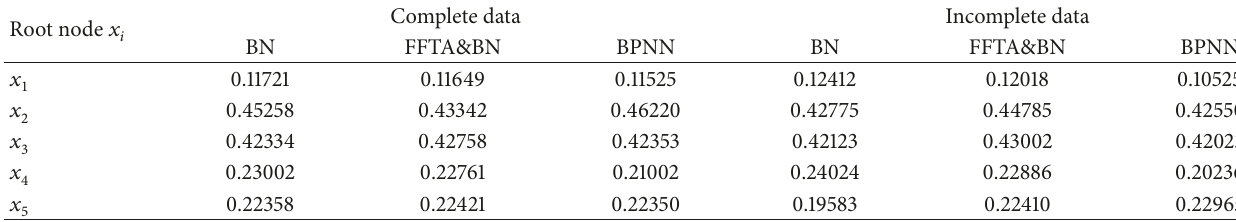
Table 10: Fault probability of root node when the state of leaf nodes is